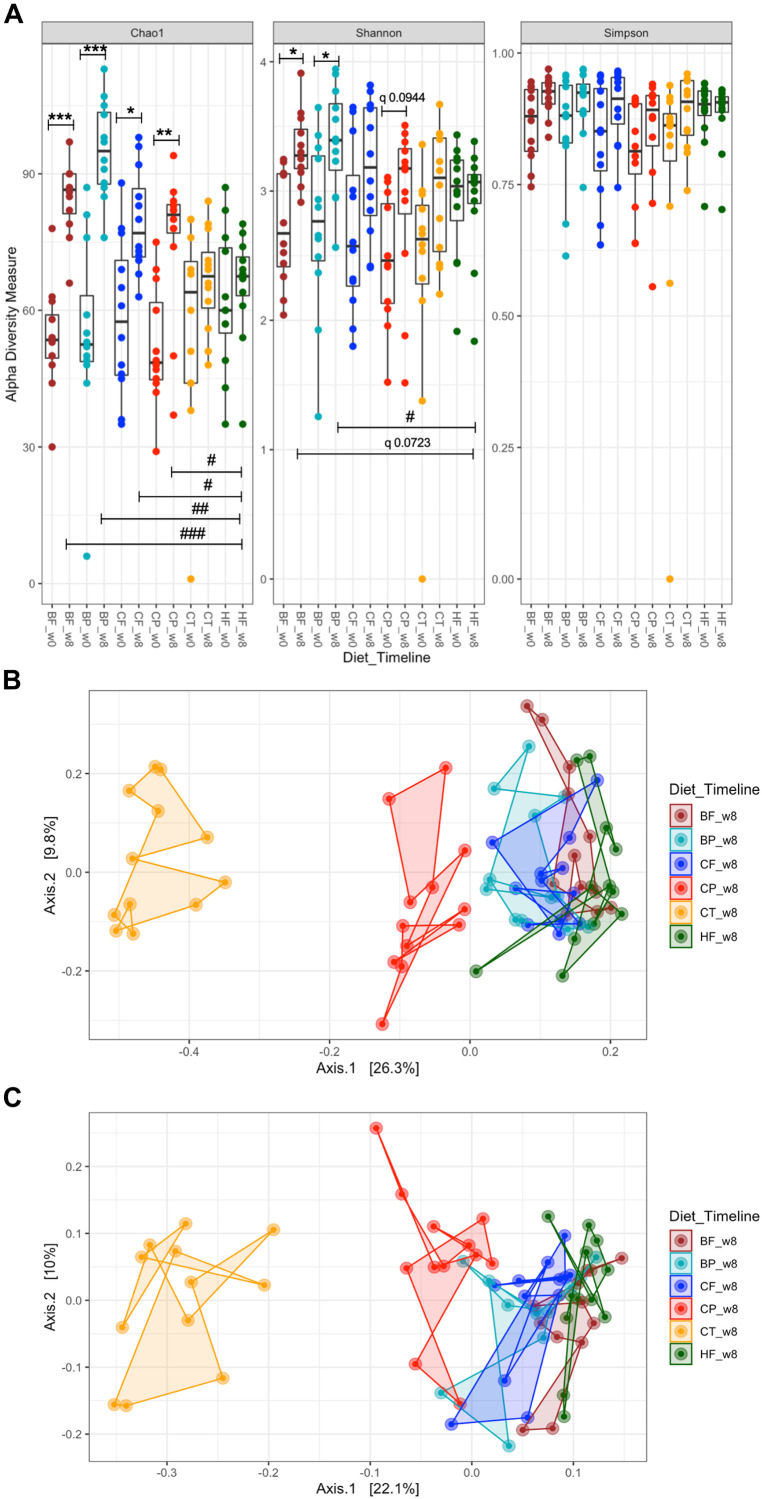
Polyphenol-rich CP and BP and their fiber-rich CF and BF distinctly influenced the gut microbiota structure of HFHS-induced obese mice. Mice were fed a HFHS-diet (HF), Chow (CT), polyphenol-rich whole cranberry powder (CP), cranberry fiber-rich fraction (CF), polyphenol-rich whole blueberry powder (BP) and blueberry fiber-rich fraction (BF). (A) α-diversity, determined by Chao1, Shannon-diversity and Simpson-evenness plotted for each dietary group at 0 and at 8-weeks. Line inside the box represents the median, while whiskers represent the lowest and highest values within 1.5 interquartile range (IQR); (B) Principal Coordinates Analysis (PCoA) plot of Bray–Curtis dissimilarities between samples at 8-week (PERMANOVA R2 0.40295, p < 0.001); (C) PCoA of taxon phylogenetic tree-based unweighted UniFrac of samples at 8-week (PERMANOVA R2 0.3354, p < 0.001). α-diversity significances are represented as *p < 0.05, **p < 0.01, and ***p < 0.001 as compared to baseline within the same group, and #p < 0.05, ##p < 0.01, and ###p < 0.001 as compared to HFHS at 8-week. Corrected p-values having a tendency are indicated as “q”. Each sample point (n = 12 per group) is color-coded based on the administered diet for 8-weeks, as shown in each figure legend.